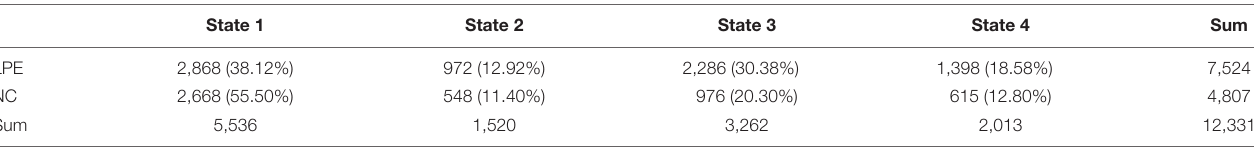
TABLE 2 | The number of windows in each state in the LPE and NC